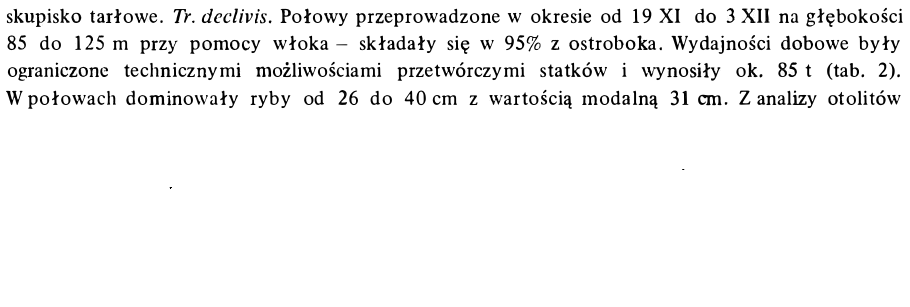
skupisko tartowe. Tr. declivis. Polowy przeprowadzone w okresie od 19 XI do 3 XII na